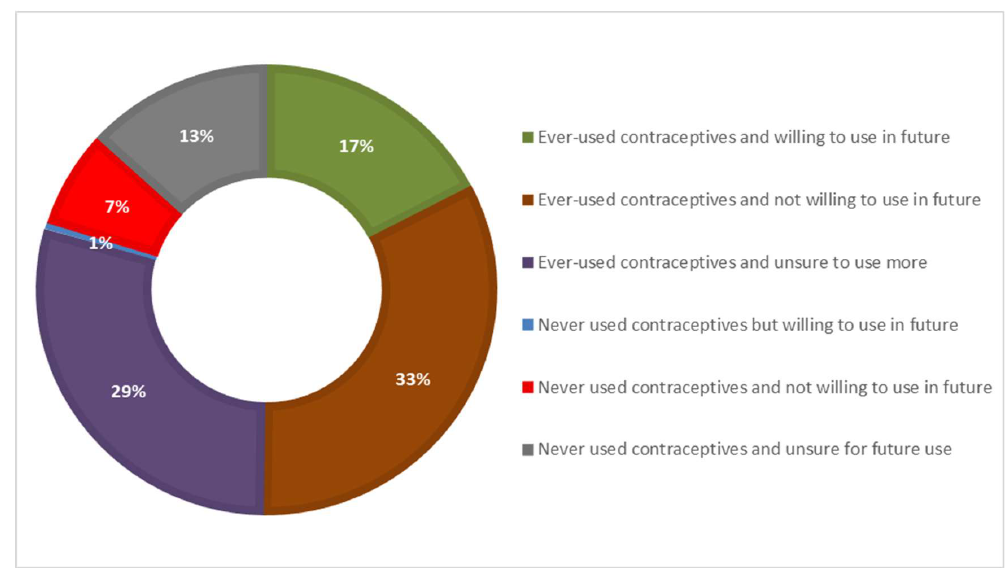
Figure 4. Percentage distribution of previous use and non-use of contraceptives and intention to use in the future; among the women with unmet need for family planning. A large proportion of the women (nearly 80%) within the unmet need group had ever-used contraceptives. Only 18% of the unmet need group were willing to use contraceptives in the future.